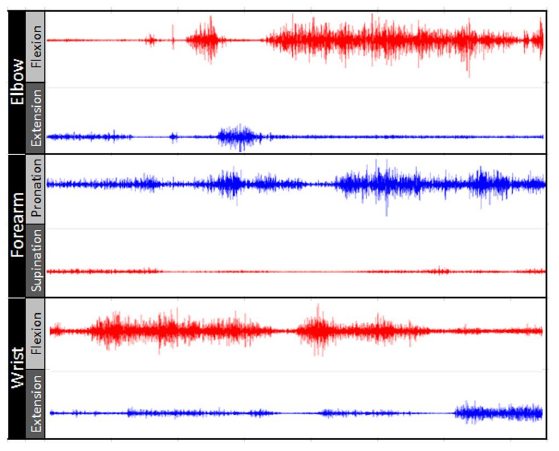
Figure 6. Elbow, forearm and wrist range of motion (ROM) assessments on the patient using EMG